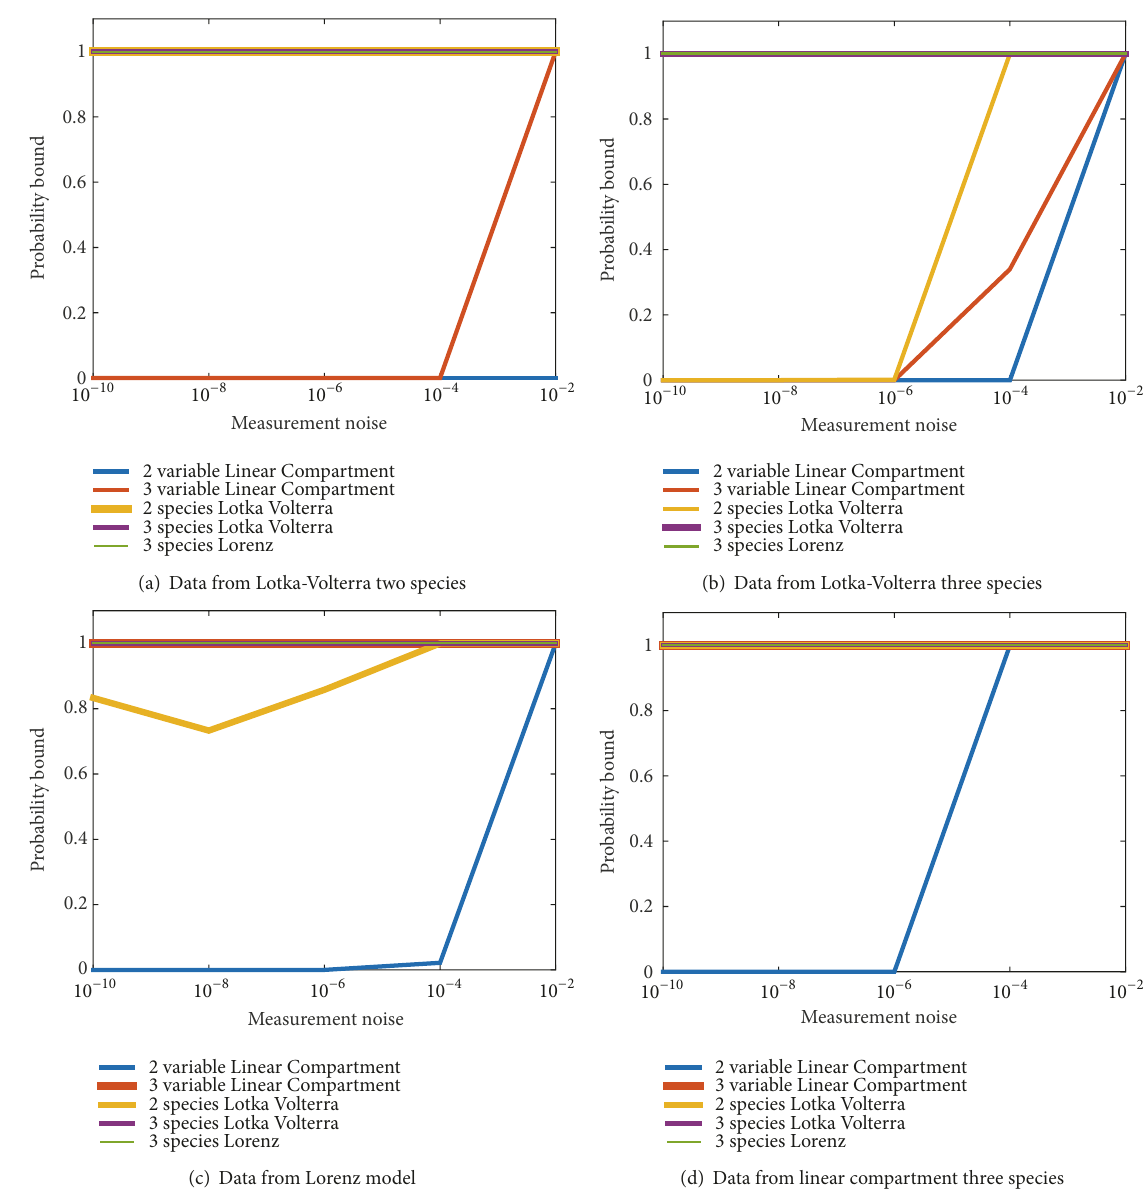
Figure 1: Data simulated from model specified and differential algebraic statistics model rejection applied to five model invariants. Gaussian noise is added to data in factors of 10 at levels shown in the figure. (a) Data simulated from two species Lotka-Volterra model with parameter values 𝑝 1 , 𝑝 2 , 𝑝 3 , 𝑝 4 = [1.24; 1.68;3.26;0.38] and initial condition [10, 1] . (b) Data simulated from three species Lotka-Volterra model with parameter values 𝑝 1 , 𝑝 2 ,𝑝 3 ,𝑝 4 , 𝑝 5 , 𝑝 6 , 𝑝 7 = [0.178; 0.12; 0.99;0.17;0.03; 0.56;0.88] and initial condition [2, 1,1] . (c) Data simulated from the Lorenz model with parameter values 𝑝 1 , 𝑝 2 ,𝑝 3 = [3.5, .3, 2.8] and initial condition [2,1, 1] . (d) Data simulated from the linear compartment three species model with parameter values 𝑝 11 , 𝑝 12 ,𝑝 13 , 𝑝 21 , 𝑝 22 ,𝑝 23 , 𝑝 31 , 𝑝 32 ,𝑝 33 = [−2,1, 0,1,−3, 1,0, 1, −2] and initial condition [3, 1, 5]